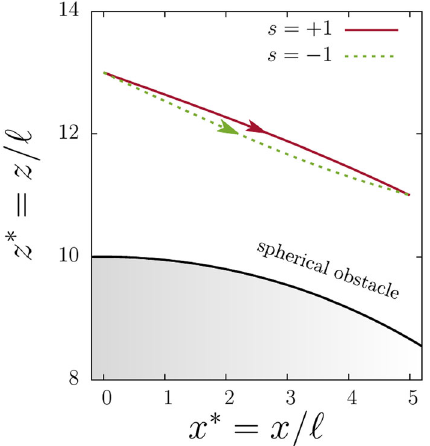
Fig. 3 Zoom of optimal swimming trajectories close to a spherical boundary. The trajectories are directed from (0,0,13) to (5,0,11) for source dipole microswimmers near a spherical boundary of scaled radius R * = 10 positioned at the center of the system of coordinates. Here, lengths are made dimensionless by ℓ and s = ±1 is the sign of the source dipole coef fi cient. Physically, the singularity coef fi cients characterize the hydrodynamic fl ow induced by microswimmers in the far- fi eld